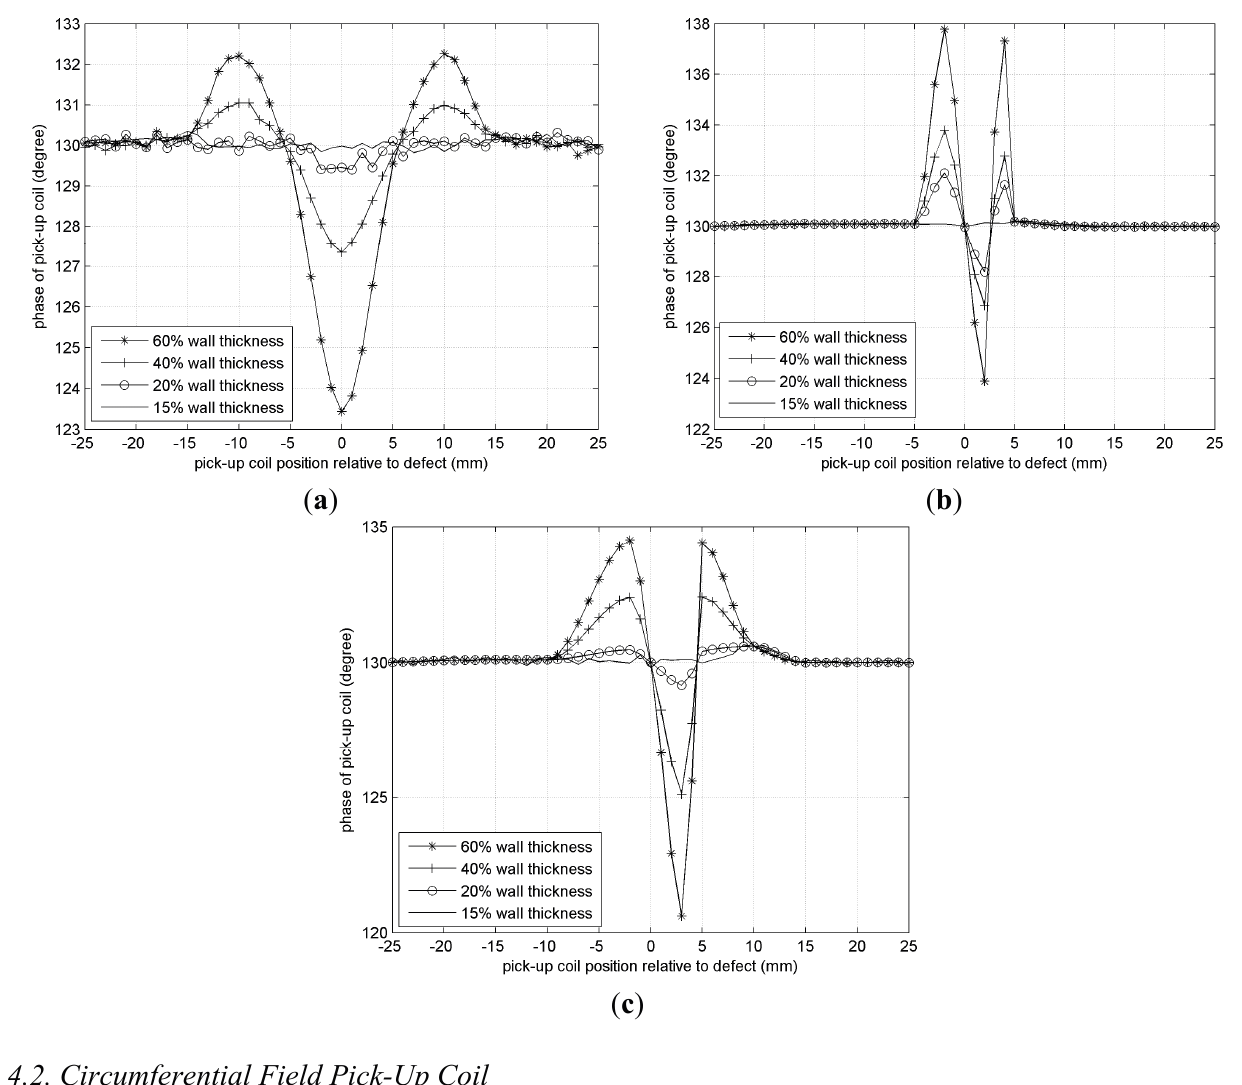
Figure 17. Detection results. ( a ) Axial crack; ( b ) Circumferential crack; ( c ) Circular